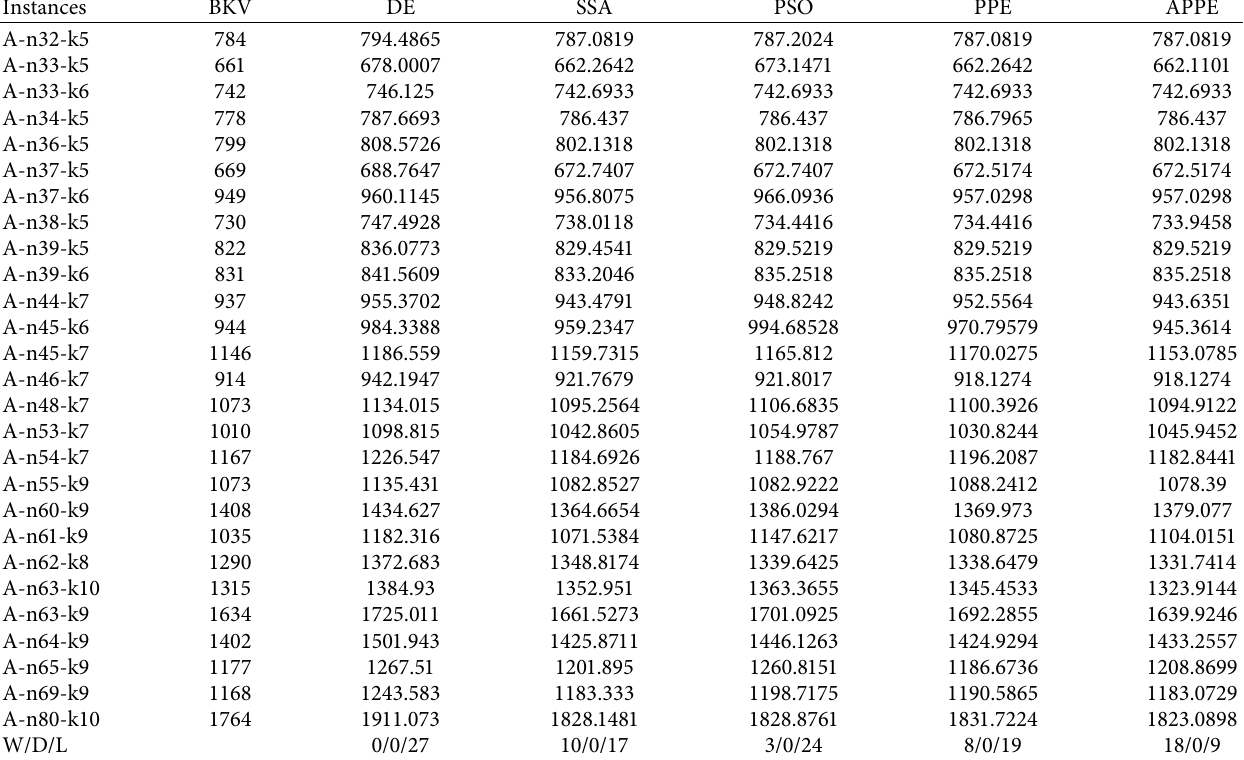
Table 14: Comparison of the best result of 10 runs in CVRP instances.